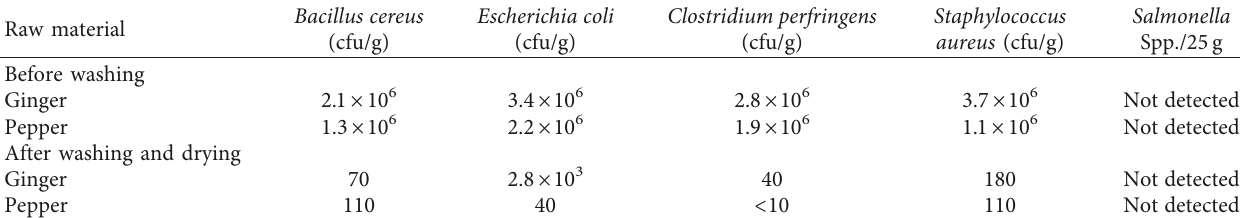
Table 6: Level of hazards in contaminated raw